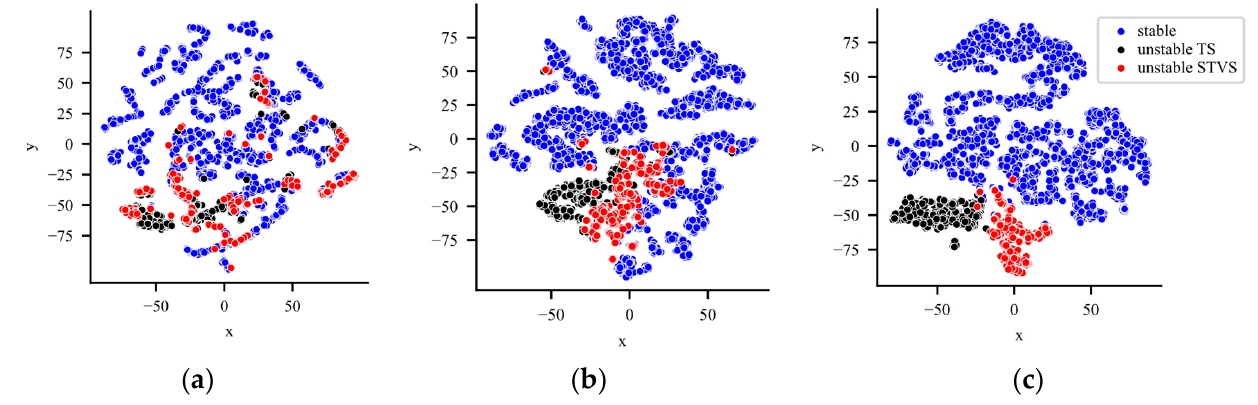
Figure 10. RCNN learning process visualization. ( a ) Sample points in the input space. ( b ) Sample points in the CNN module output space. ( c ) Sample points in the output space of the penultimate FC layer.